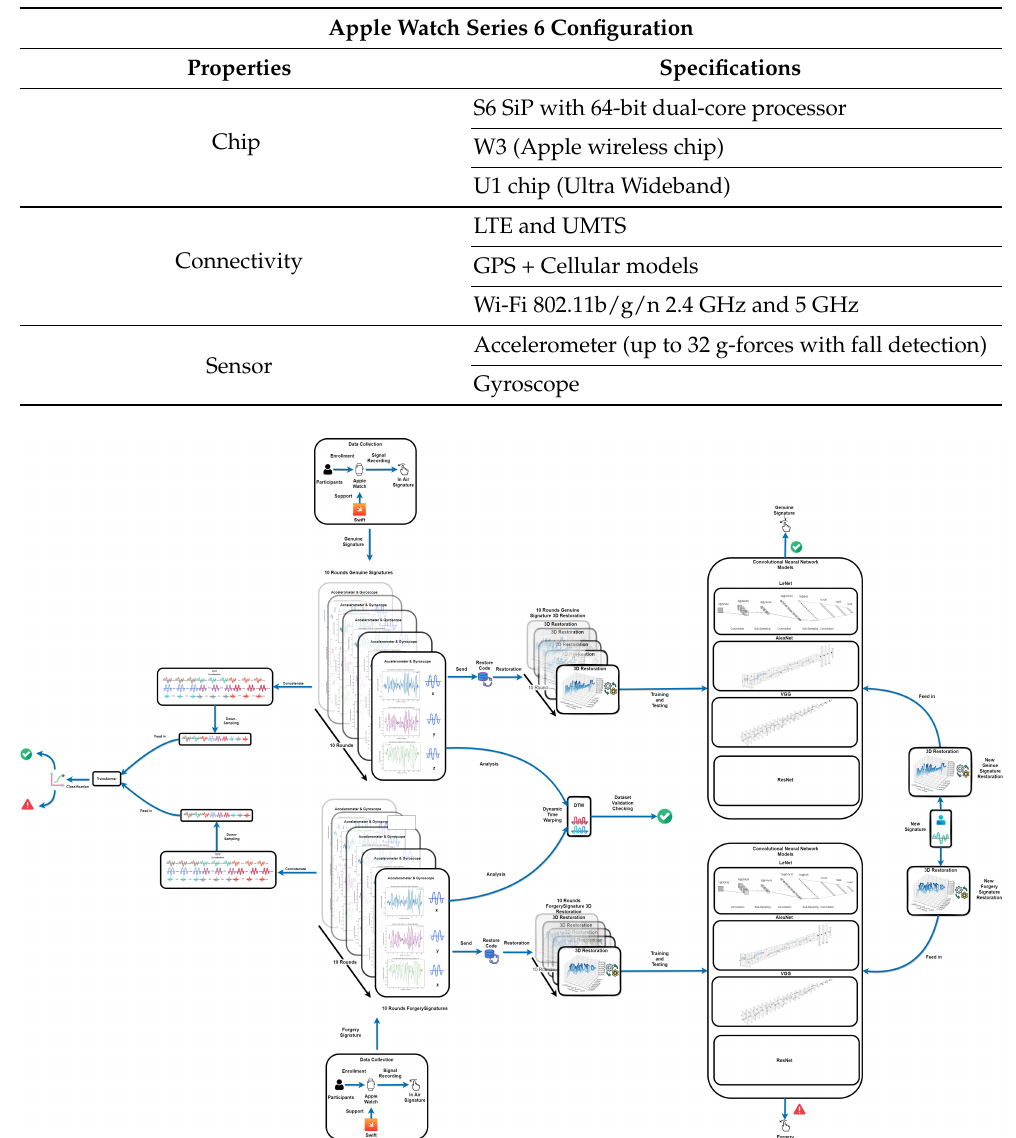
Figure 1. Experiment System architecture for a smartwatch’s in-air recognition. Please note the data collection phase using swift was conducted by Li [4] in his previous research. The convolutional layer experiment section is based on AlexNet [16], LeNet [15], VGG [17], and ResNet [18]. The transformer experiment section is based on the original transformer paper